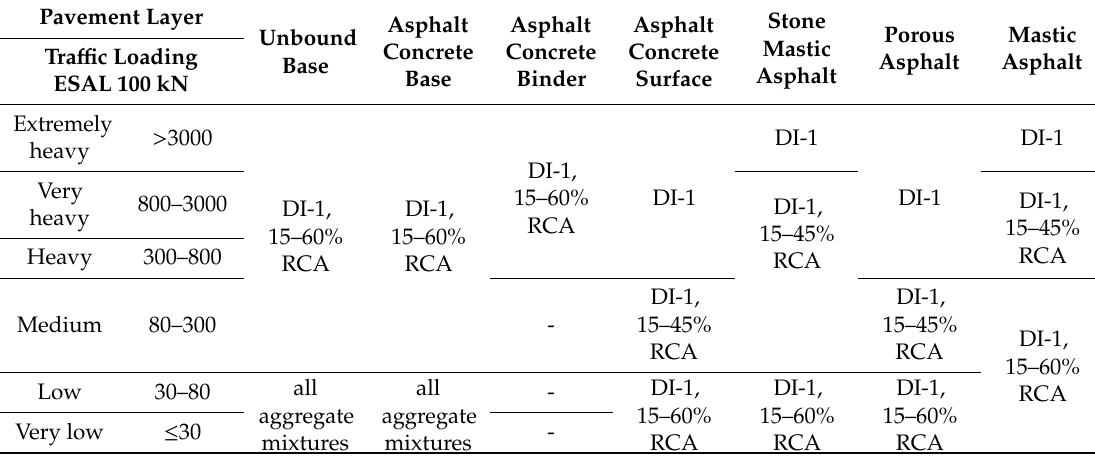
Table 5. The possibility of using RCA in flexible pavements according to technical requirements in